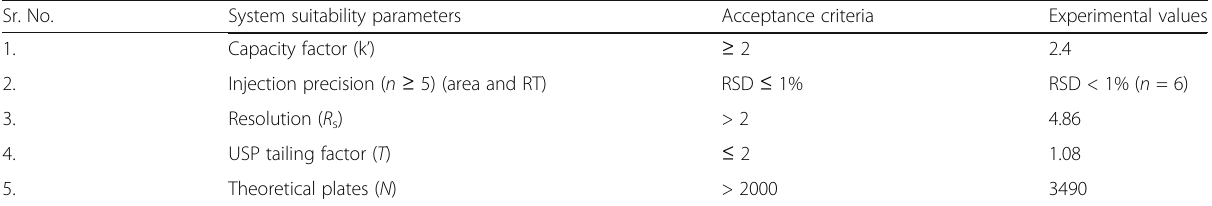
Table 1 Experimentally recorded system suitability method parameters for BQF and their recommended limits Sr. No.